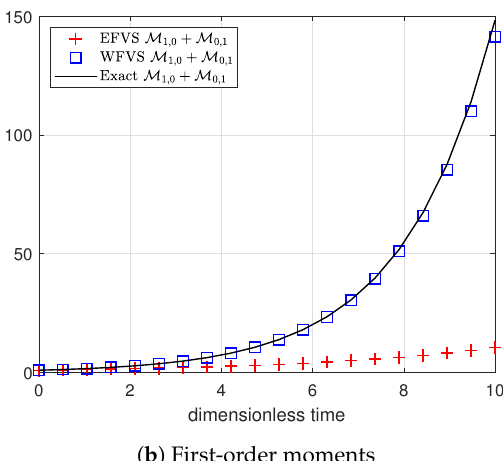
( b ) First-order moments Figure 5. Comparison of different moments with selection function S = 1, and breakage function b 4 . Table 8. Relative error for the weighted moments at different grid points for the test case with S = 1 and breakage functions b 4 at t = 10.